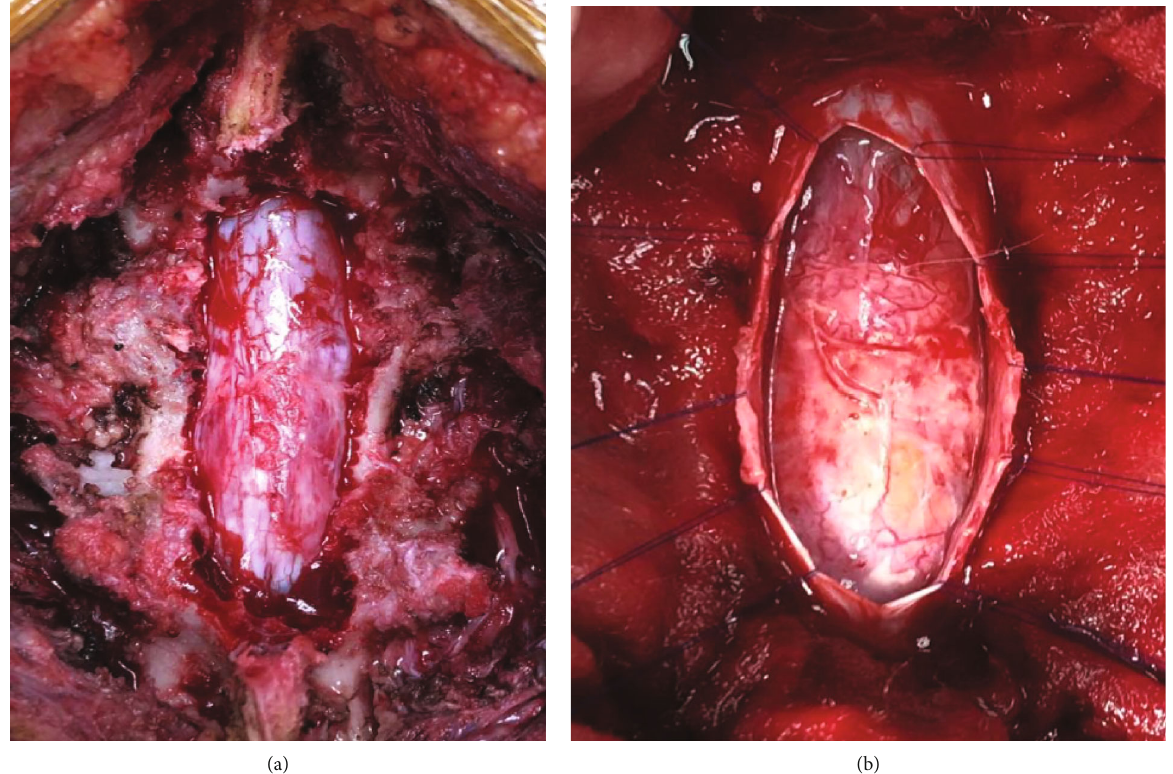
Figure 2: (a) Expansion of the dura seen after laminectomy at the L3-L4 level. (b) Cystic lesion evident after durotomy was